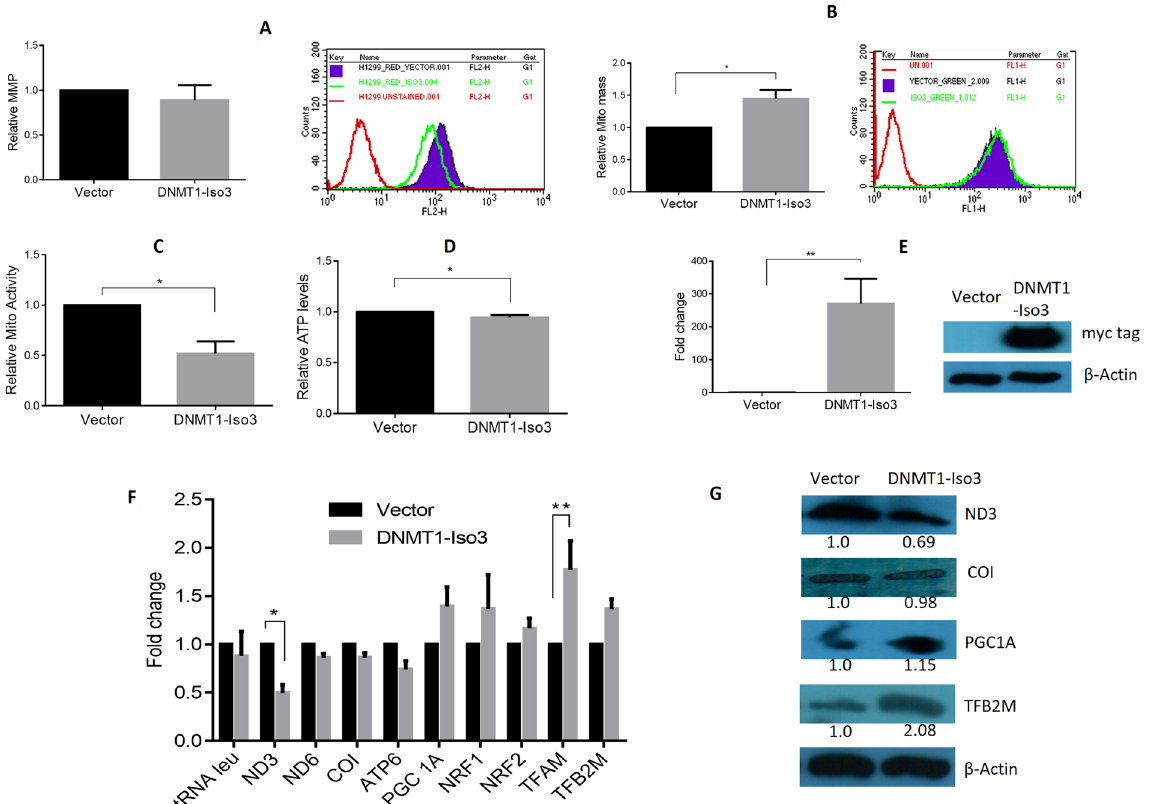
Figure 5. Exogenous overexpression of DNMT1-isoform3 affects mitochondrial biology. Representative screen shots and bar diagram for relative: ( A ) mitochondrial membrane potential; ( B ) mitochondrial mass; ( C ) mitochondrial activity; ( D ) ATP levels on exogenous overexpression of DNMT1-isoform3 in H1299 cells. ( E ) The real time and Western profile of DNMT1-iso3 overexpressing cells. ( F ) Semi-quantitative gene expression profile and ( G ) Western blot scans of selected mtDNA encoded and nuclear genome encoded mt genes in overexpressing DNMT1-iso3 H1299 cells. Relative fold of expression of the analyzed protein was